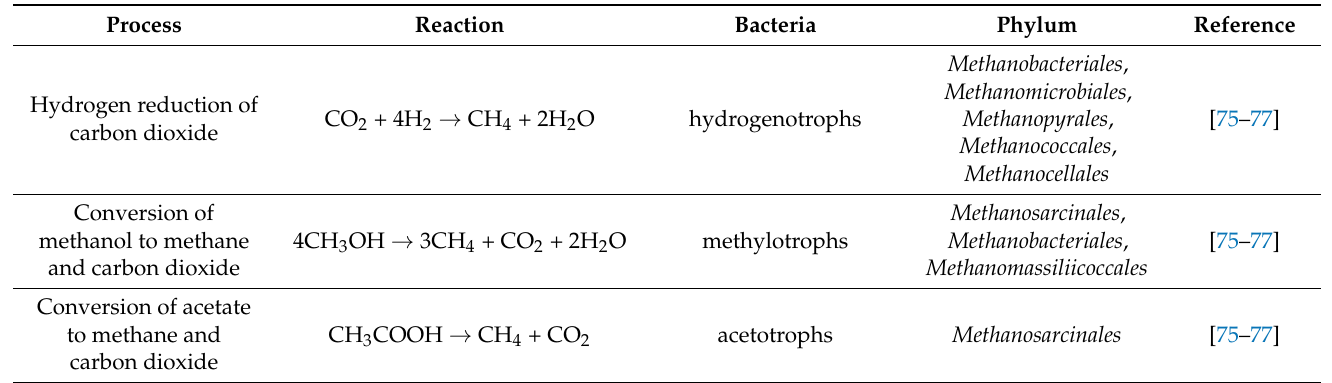
Table 2. Stoichiometric reactions for methane production via